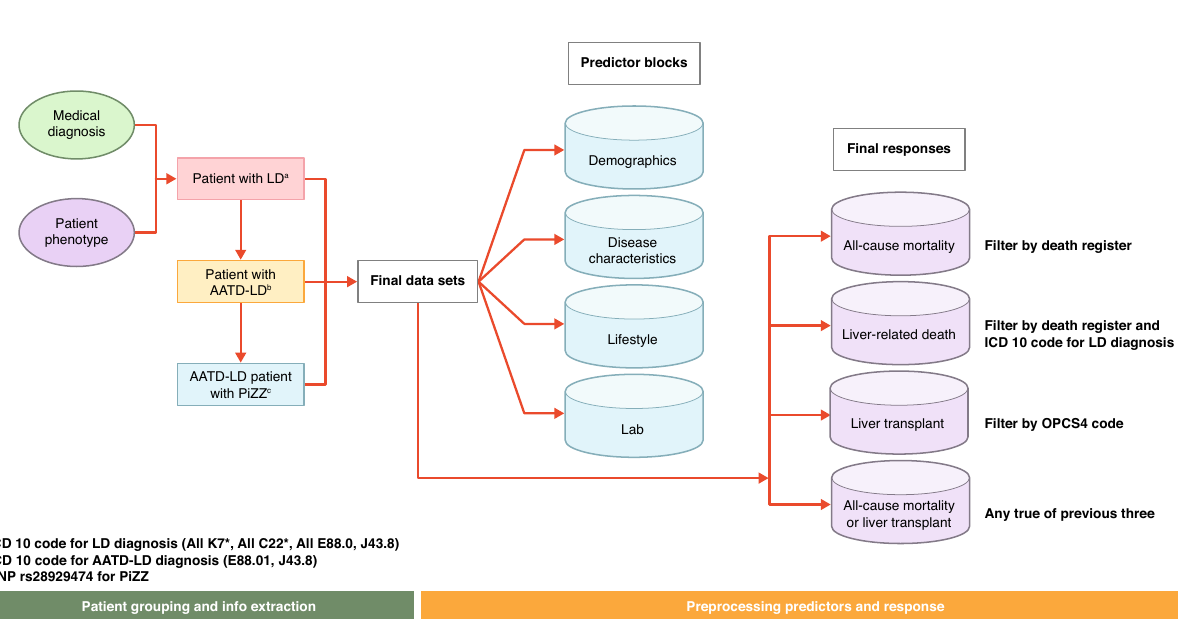
Figure 2. Flow chart of data assembly, processing, and